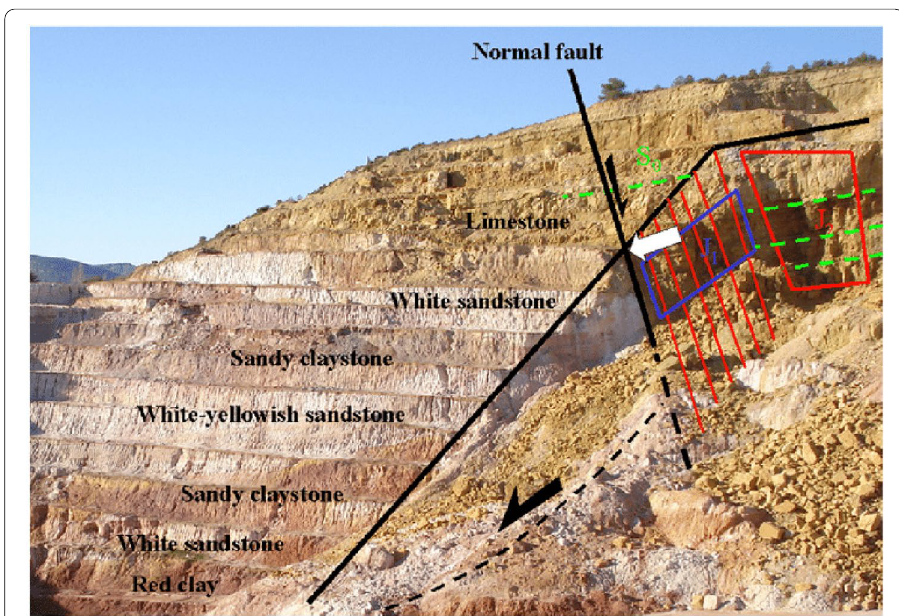
Fig. 2 The Valencia Open Surface mine with the slide-head-toppling in Spain